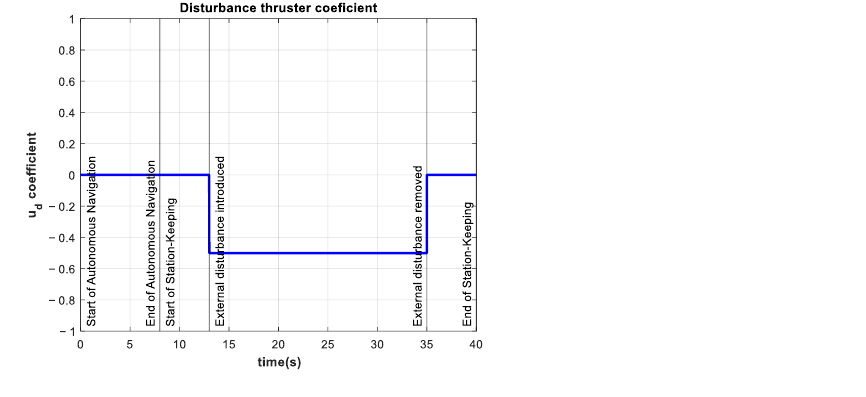
Figure 18. Additional thruster coefficient of −0.50 in the interval 13 s ≤ 𝑡 ≤ 25 s .